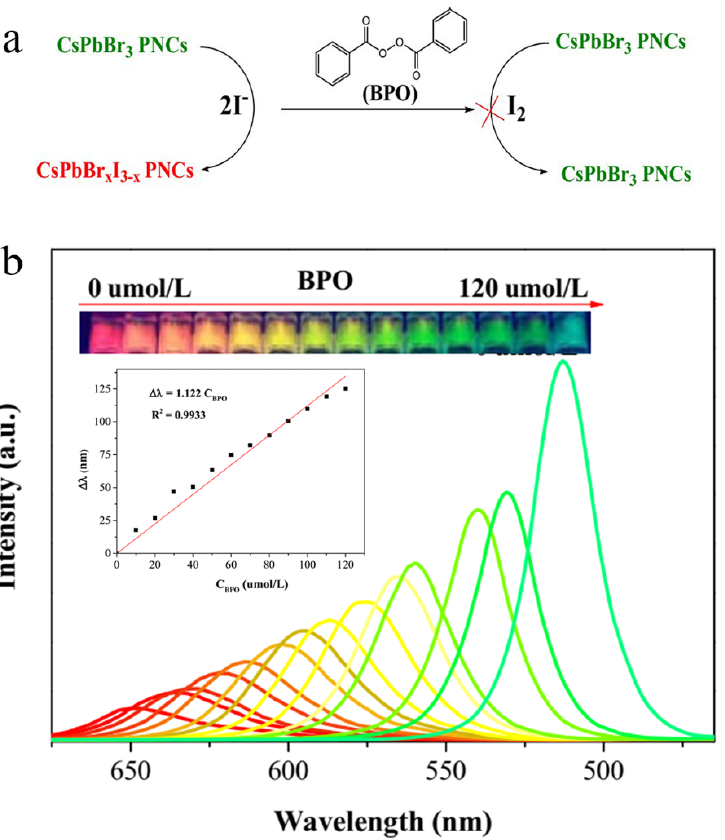
Figure 7. ( a ) Schematic mechanism illustration of wavelength shift-based fluorescence colorimetric sensing of BPO based on the CsPbBr 3 PNCs halide exchange caused by the oxidation reaction between OLAM-I and BPO; ( b ) Fluorescence spectrum changes when CsPbBr 3 PNCs halide exchange with 240 μ mol L − 1 OLAM-I under the different concentrations of BPO from 0 to 120 μ mol L − 1 ; inset, the linear relationship between the BPO concentration and the corresponding wavelength-shift ( Δλ ).